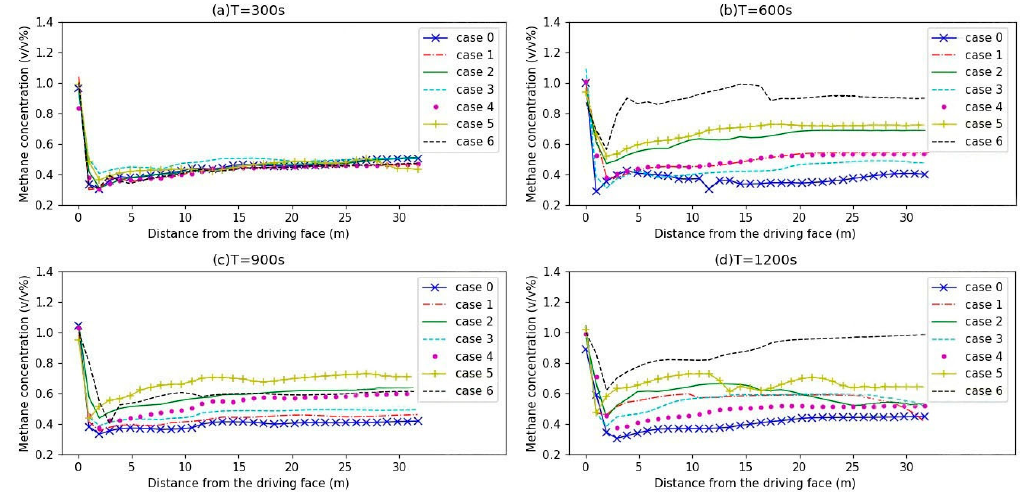
Figure 6. Average methane concentration along the selected line.